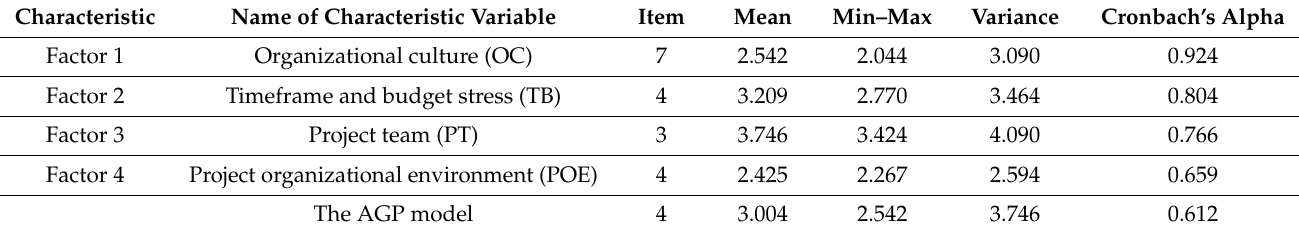
Table 6. Cronbach’s